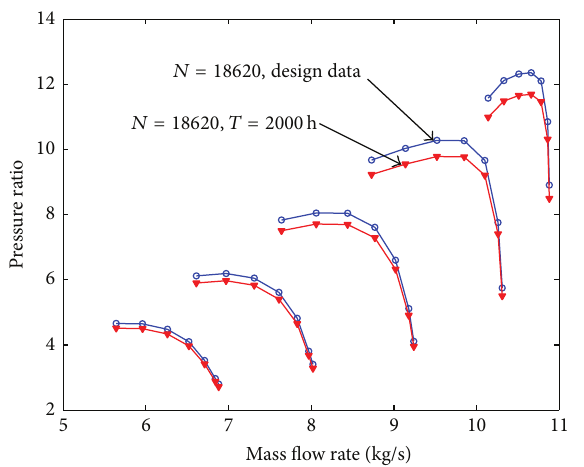
Figure 9: The pressure ratio curve in design and fouled condition when operating time is 2000 hours.